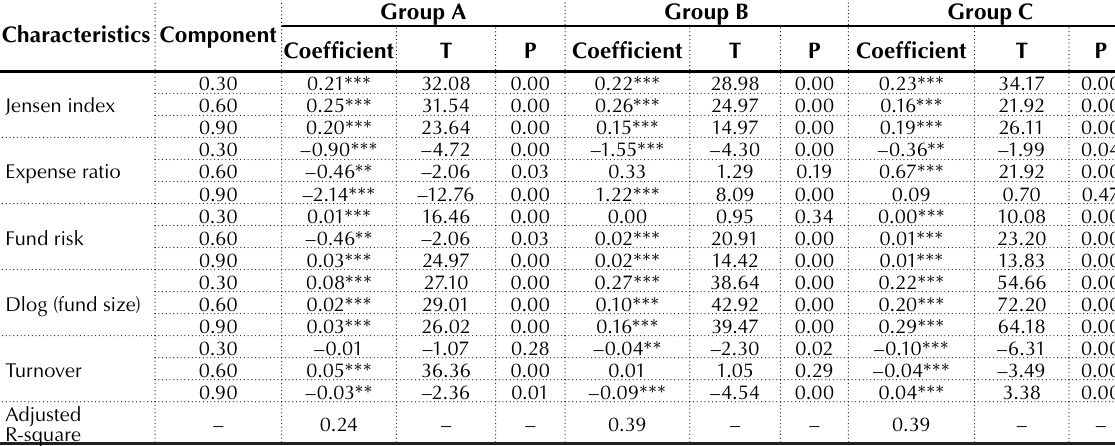
Table 11. Fund inflow, performance and fund characteristics Group A Group B Group C Characteristics Component